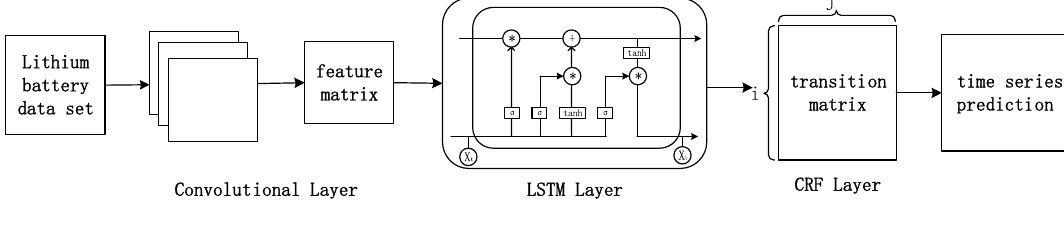
Figure 1. Network model framework.